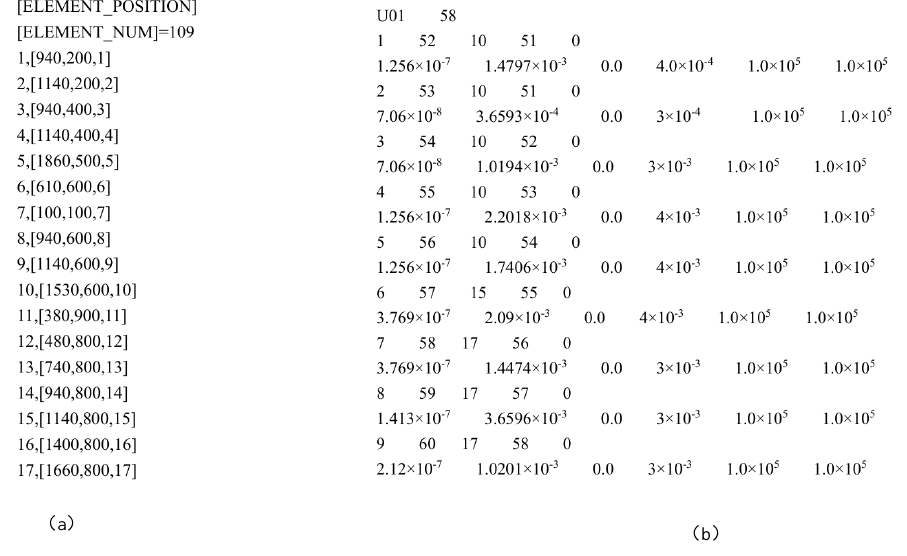
Figure 36. Extracted data sample: ( a ) Units position and number; and ( b ) unit data